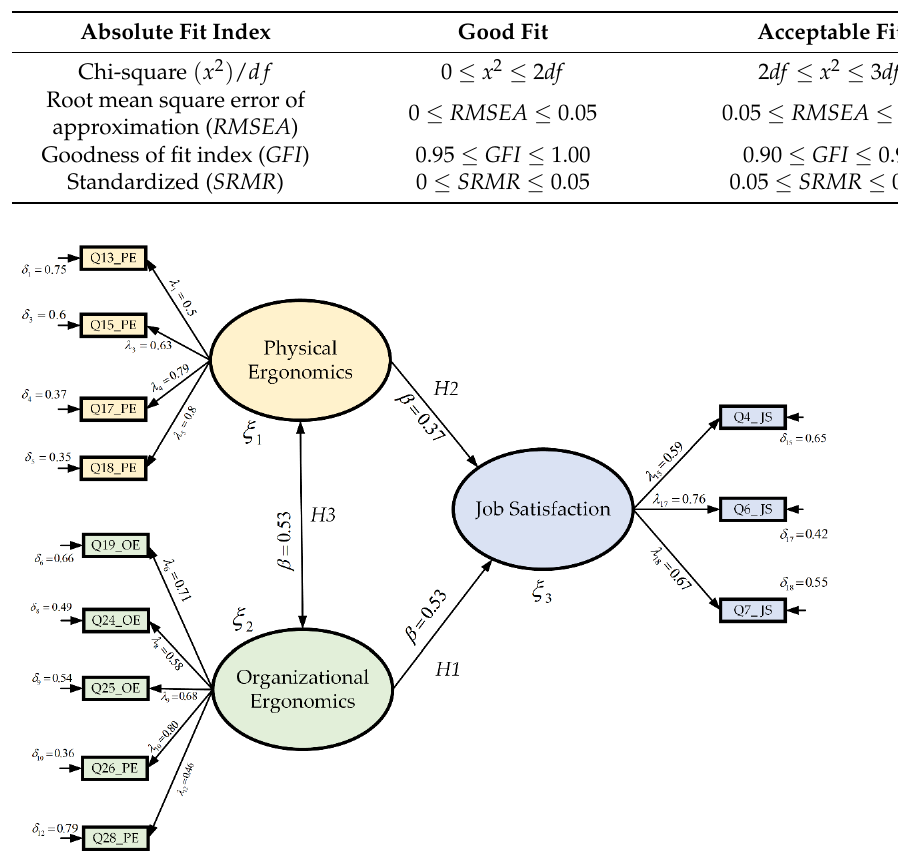
Figure 3. The final test concerning JS with PE and OE.